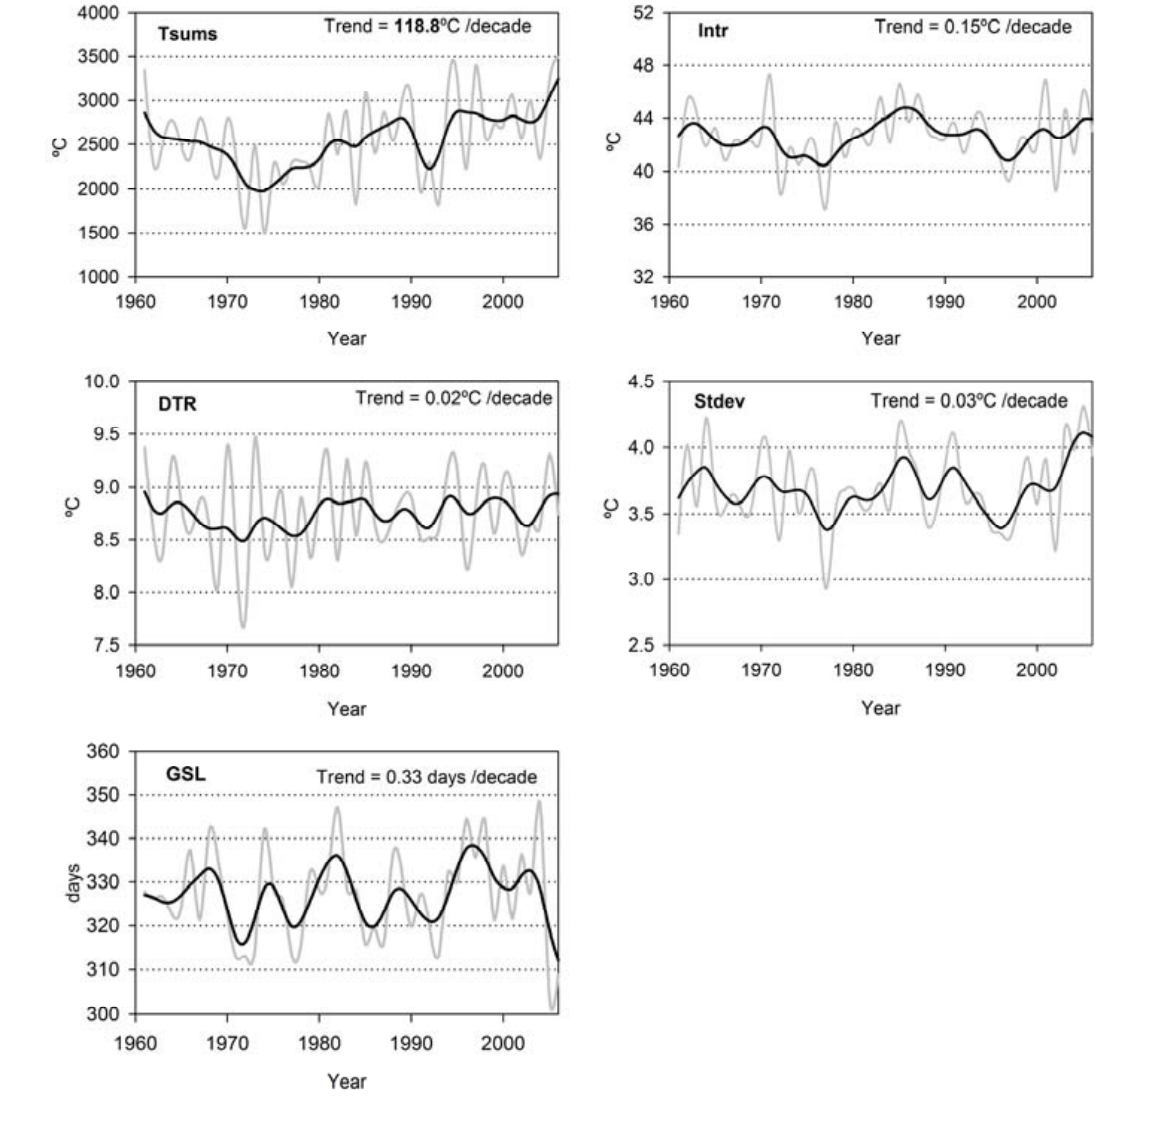
Figure 12. The same as Figure 7, but for variability indices. Fig. 12. The same as Fig. 7, but for variability